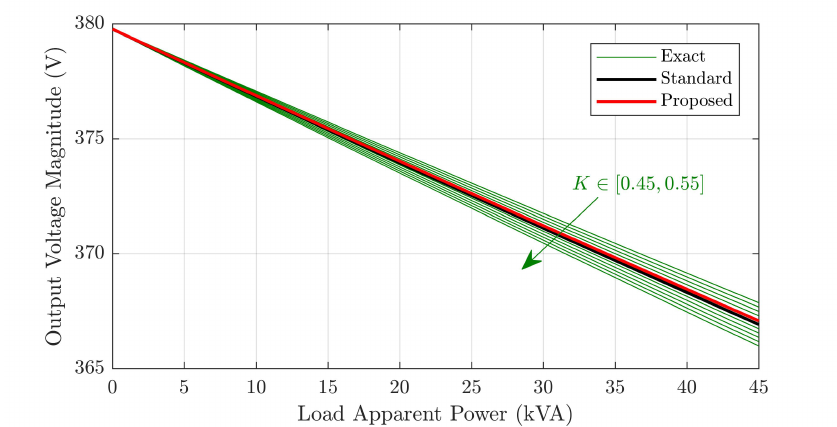
Figure 10. Output voltage magnitude versus load for the different